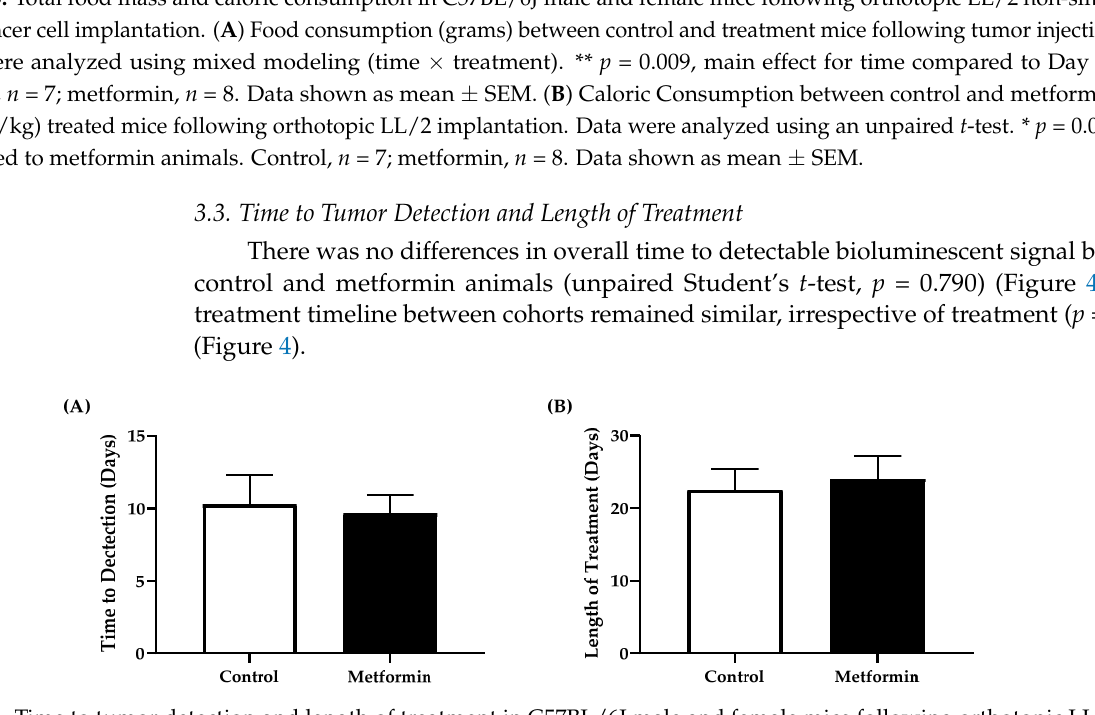
Figure 4. Time to tumor detection and length of treatment in C57BL/6J male and female mice following orthotopic LL/2 non-small lung cancer cell implantation. ( A ) Number of days to a discernable bioluminescent signal following orthotopic injection of LL/2 cells into C57BL/6J mice. Data were analyzed using an unpaired t -test. Control, n = 7; metformin, n = 9. Data shown as mean ± SEM. ( B ) Number of days C57BL/6J mice with NSCLC underwent treatment with control or metformin (250 mg/kg). Data were analyzed using an unpaired t -test. Control, n = 7; metformin, n = 8. Data shown as mean ± SEM.